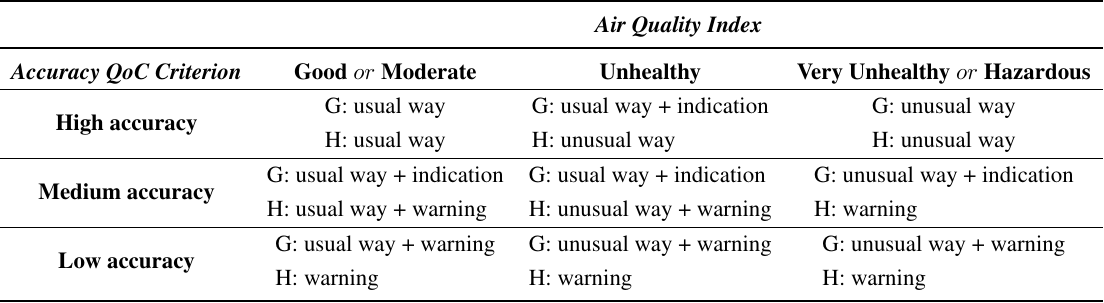
Table 4. Behavior of the applications following the context information and QoC